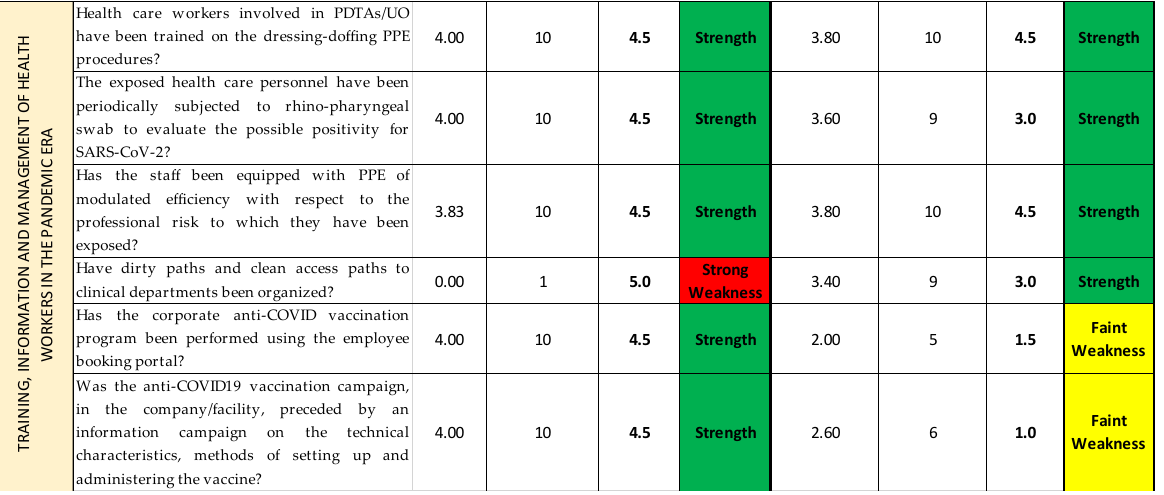
Figure 15. Summary of the results regarding all the items of the four analyzed CPs. ( A ) Results of CP1 and CP2. ( B ) Results of CP3 and CP4.